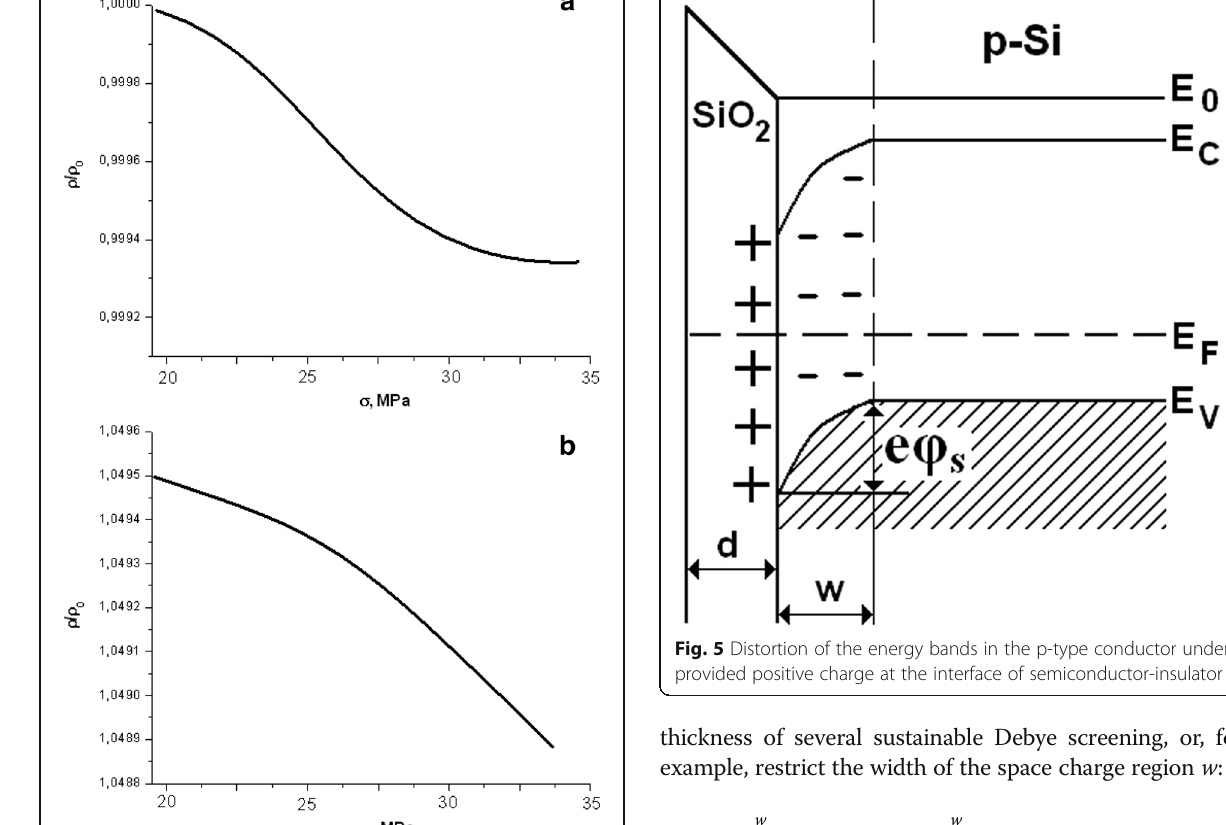
Fig. 4 Dependence of longitudinal resistance of solar silicon during